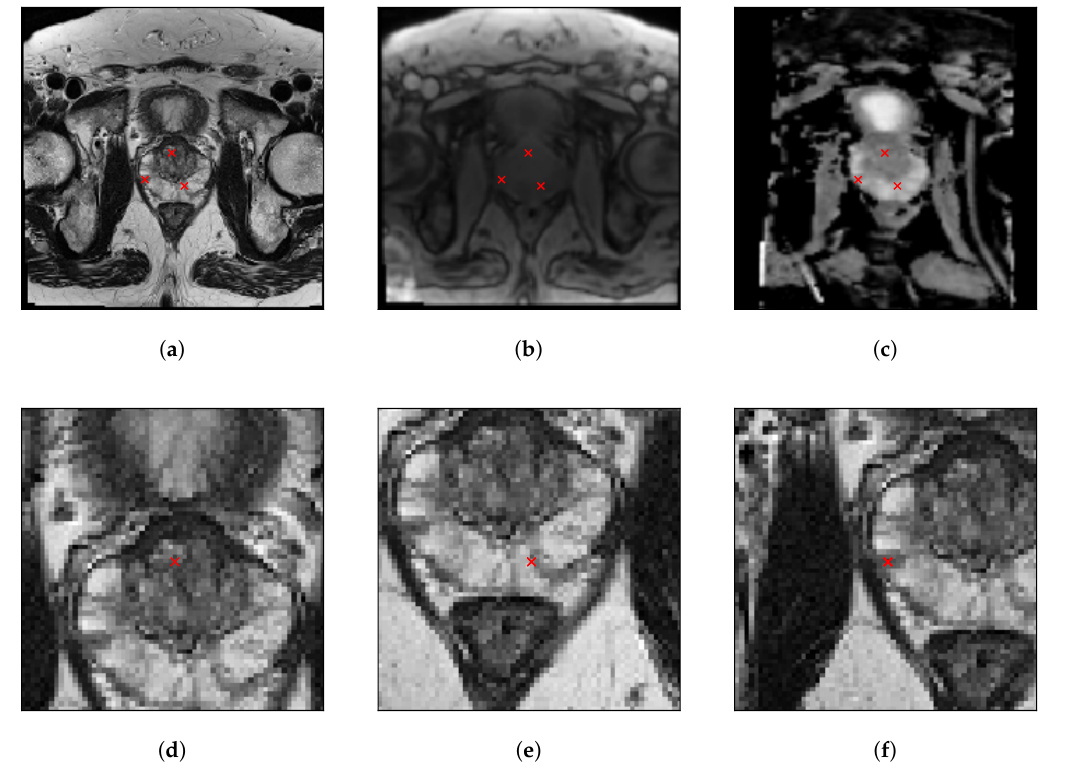
Figure 1. Example MR images from Patient #005: ( a ) T2w, ( b ) PDw, and ( c ) ADC sequences. The PCa lesions are highlighted (with red crosses) in the coordinates ( 95,92 ) , ( 103,113 ) , and ( 78,109 ) , with slice index z = 30, after the registration against the T2w MRI sequence. The three lesions are separately displayed on the T2w slice in ( d – f ). In particular, these RoIs are centered and cropped on each